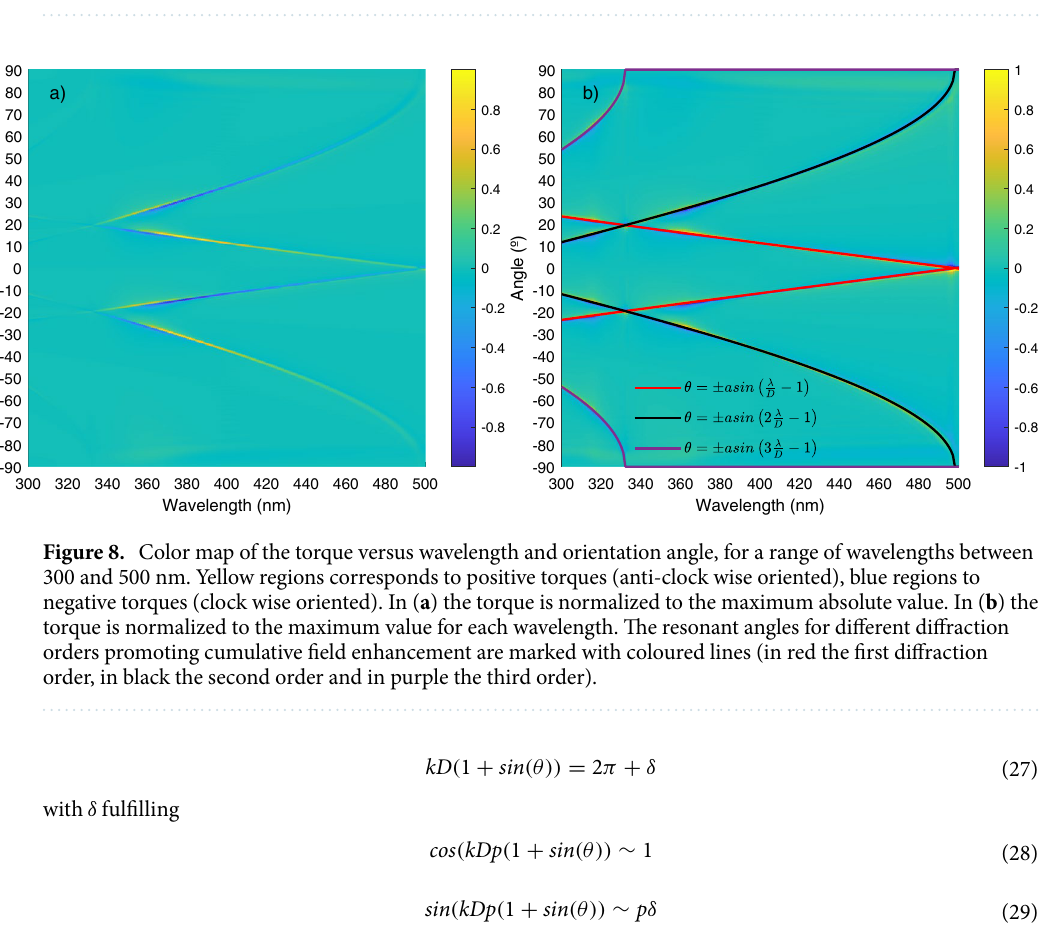
Figure 7. Normalized polar component of the force on each particle for the maximum positive torque, maximum negative torque and zero torque in the resonance region corresponding to sin (θ) = (cid:31) / D − 1 with (cid:31) = 750 nm .